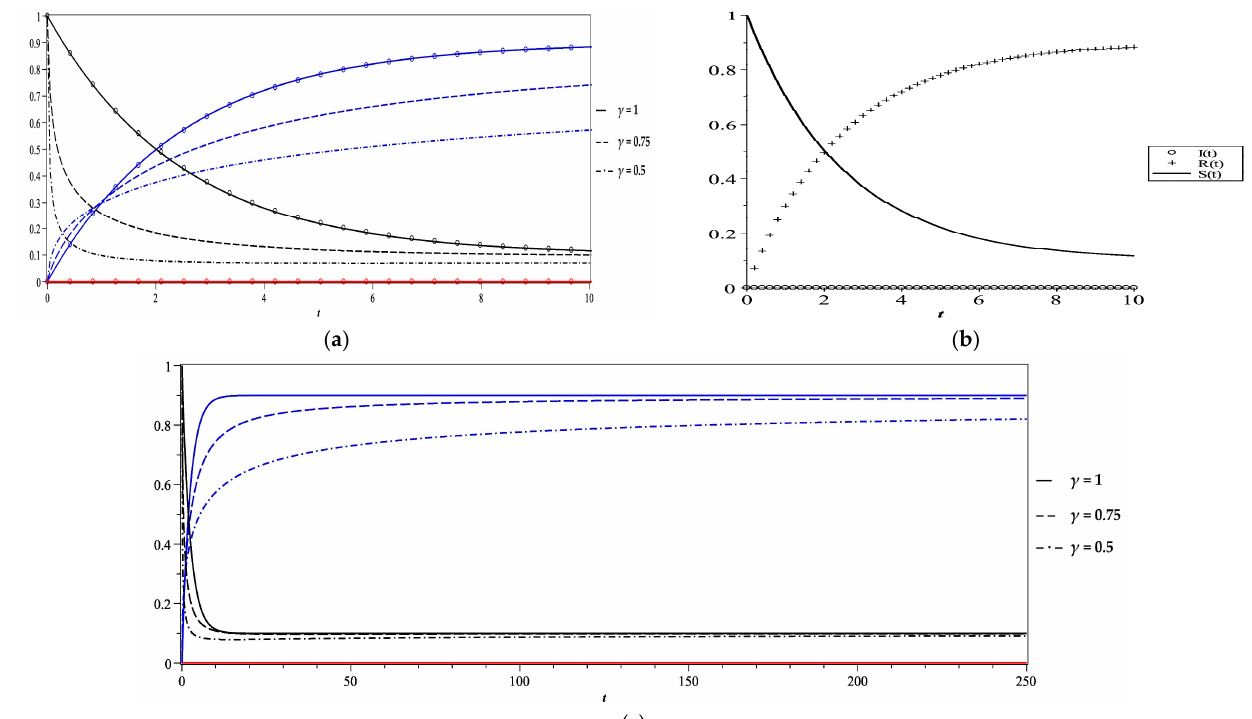
Figure 2. Behavior of various individual fractions ( S in black , I in red and R in blue) versus time for Case 1 at different fractional order values ( a ) till T = 10, ( b ) results of [3] and ( c ) till T = 250.